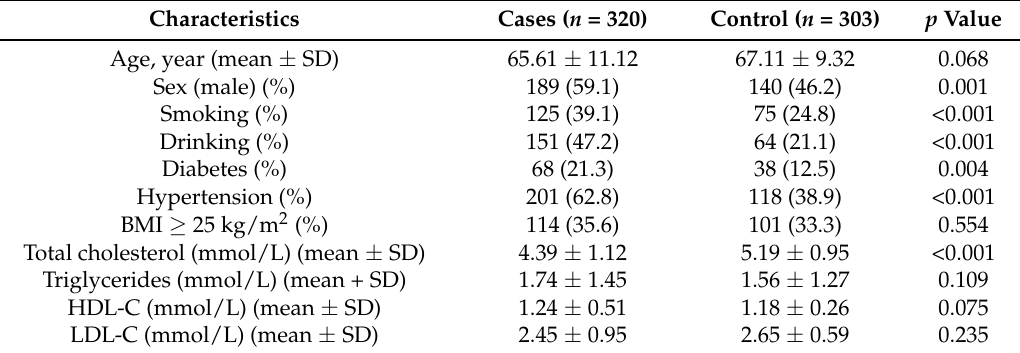
Table 1. Demographic characteristics of patients and control